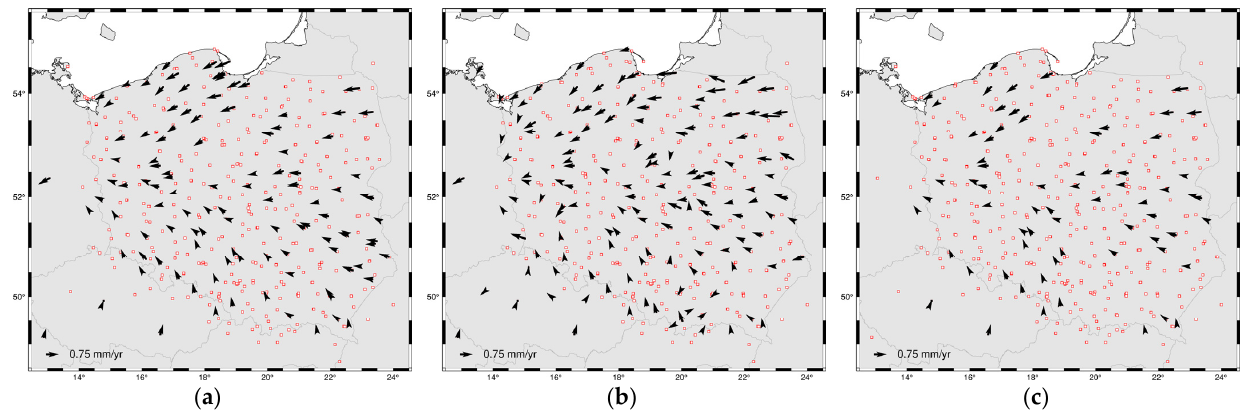
Figure 10. Horizontal local velocities (reduced by ITRF2014 plate motion model) for three datasets: DBF_100-25 ( a ), SBF_25 ( b ) and station using the two methods ( c ). Excluded stations are marked with red squares.